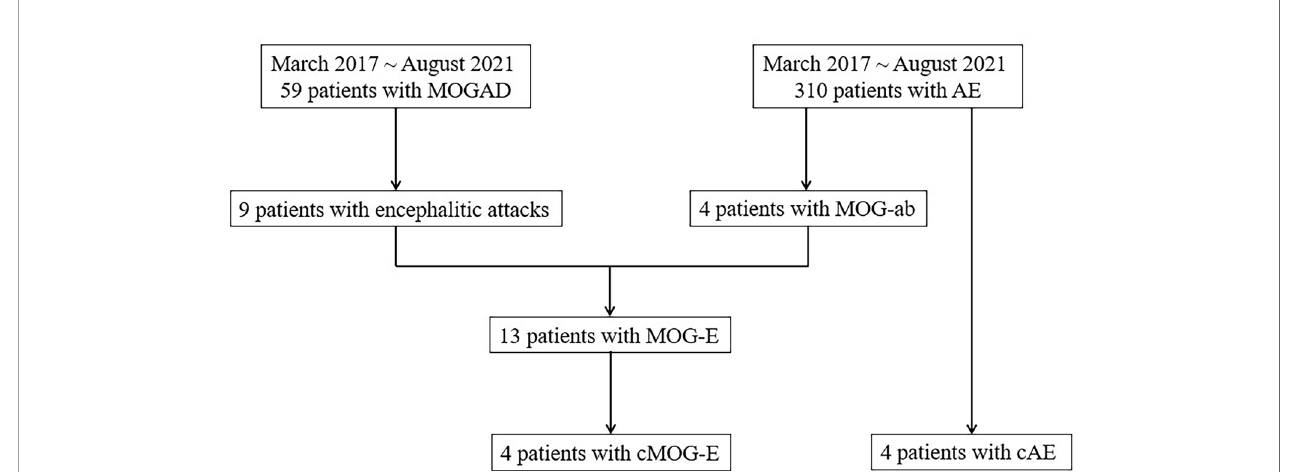
FIGURE 1 | The process of identifying patients from MOGAD and AE cohorts. ab, antibodies; AE, autoimmune encephalitis; cAE, chronically progressive autoimmune encephalitis; cMOG-E, chronically progressive myelin oligodendrocyte glycoprotein-antibodies-mediated encephalitis; MOG, myelin oligodendrocyte glycoprotein; MOGAD, myelin oligodendrocyte glycoprotein-antibodies-associated